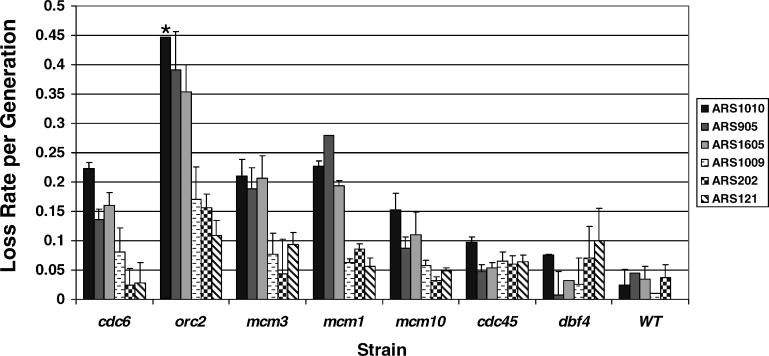
Comparing the Effect of mcm1–1 on A-Type and B-Type ARSs with Those of Pre-RC Assembly (cdc6, orc2, and mcm3) and Activation (cdc45 and dbf4) Mutants as Well as mcm10 in a mcm AssayThe asterisk indicates rate was too high to be measured. ARS1010, ARS905, and ARS1605 are B-type ARSs. ARS1009, ARS202, and ARS121 are A-type ARSs.